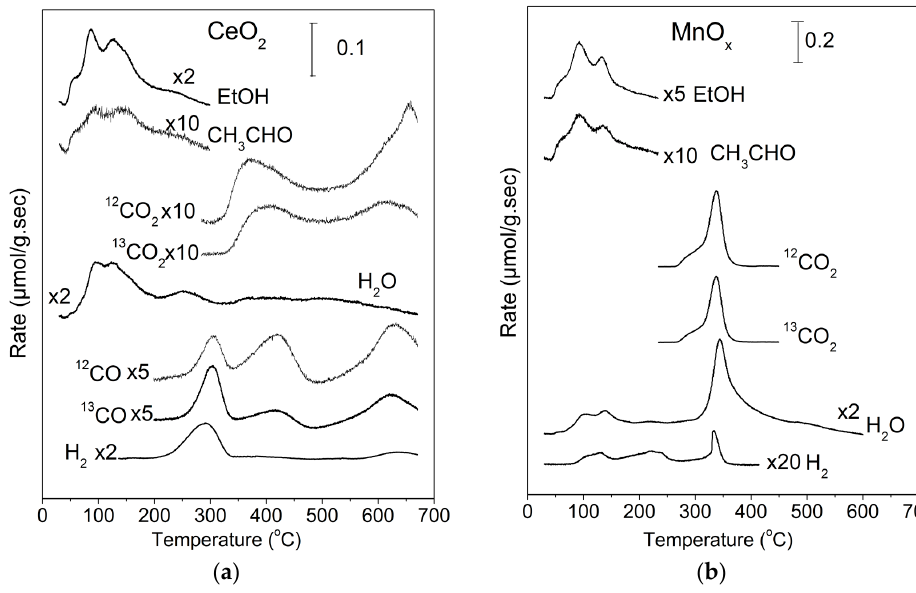
Figure 1. ( a ) TPD profiles following 12 CH 313 CH 2 OH adsorption on pure CeO 2 , ( b ) TPD profiles following 12 CH 313 CH 2 OH adsorption on pure MnO x . following 12 CH 313 CH 2 OH adsorption on pure MnO x